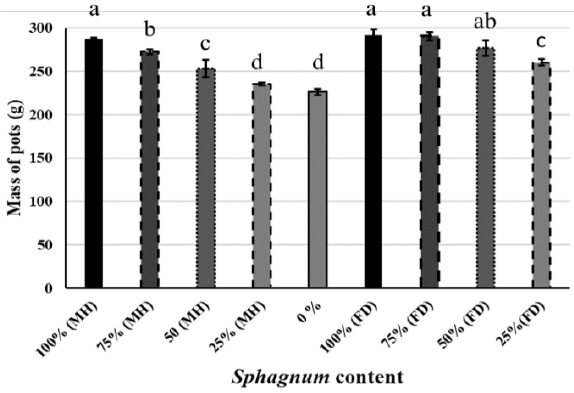
Figure 7. Average time elapsed between the beginning of the drought experiment and wilting of the verbena plants. FD = S. fuscum dominated biomass, MH = machine- harvested biomass. Differences between means (p < 0.05) are indicated by different letters (a, b). Error bars denote ± SD. n = 8.